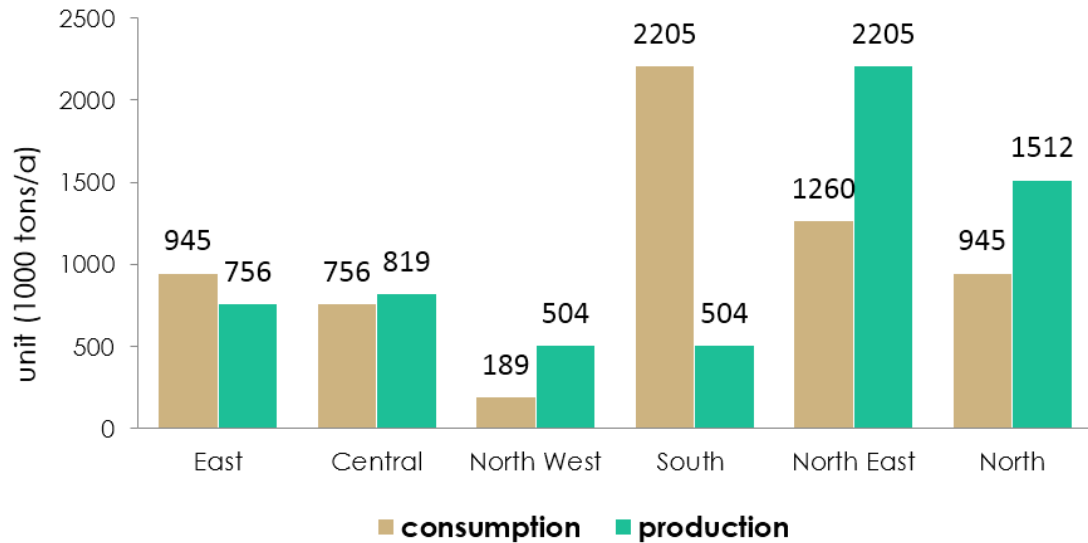
Figure 3. BMF production and consumption in China by region (2014) data source: field